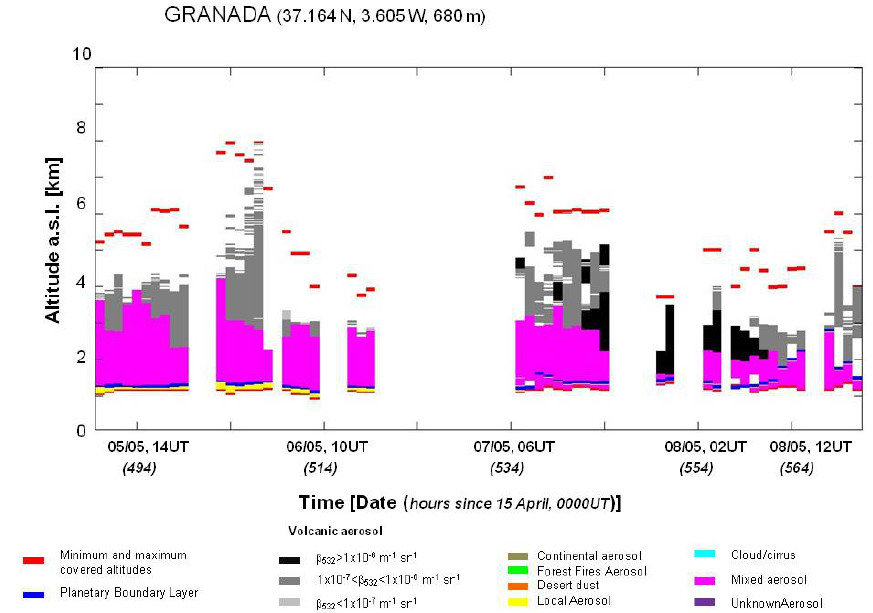
Fig. 3. Aerosol mask for the Granada EARLINET site in the 5–7 May 2010 period.